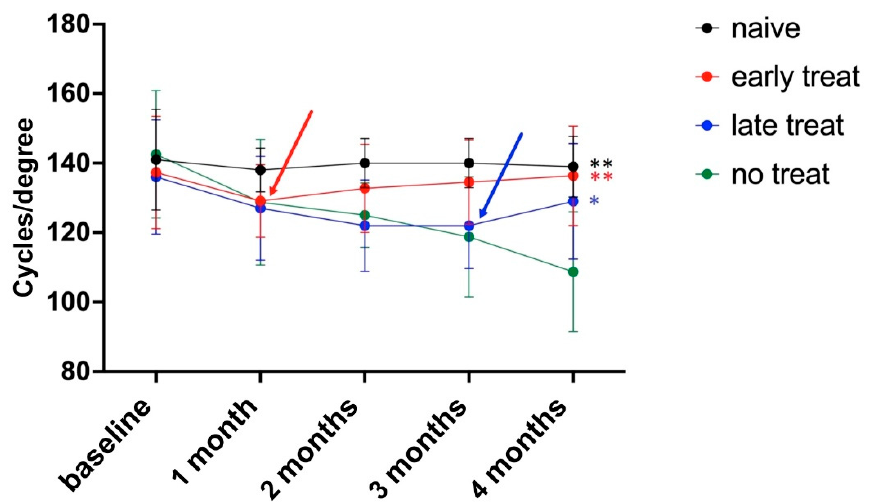
Figure 4. Pioglitazone improves visual acuity in glaucomatous mice. Induction of elevated IOP following baseline measurements leads to a decrease in OKR. Pioglitazone treatment after one month (early treatment, red line) caused a reversal of these deficits. Pioglitazone treatment in mice with more advanced damage (late treatment group, blue line) prevents further functional decline and partially reverses losses. Arrows indicate the start of pioglitazone treatments. ** p < 0.01; * p > 0.05.